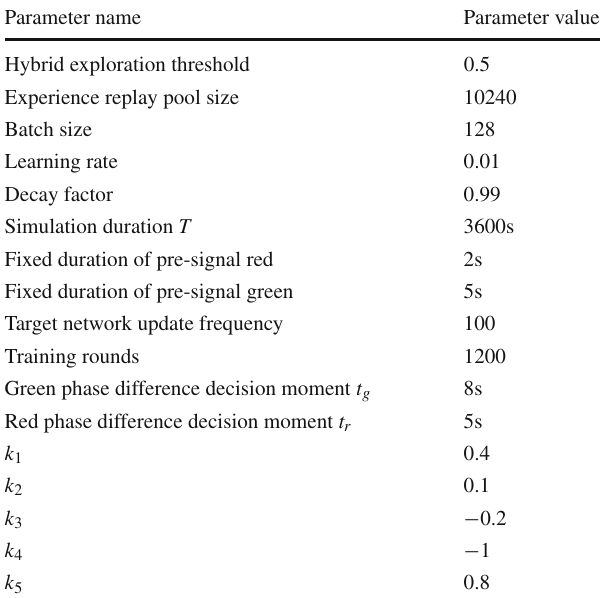
Table 2 Experimental parameter